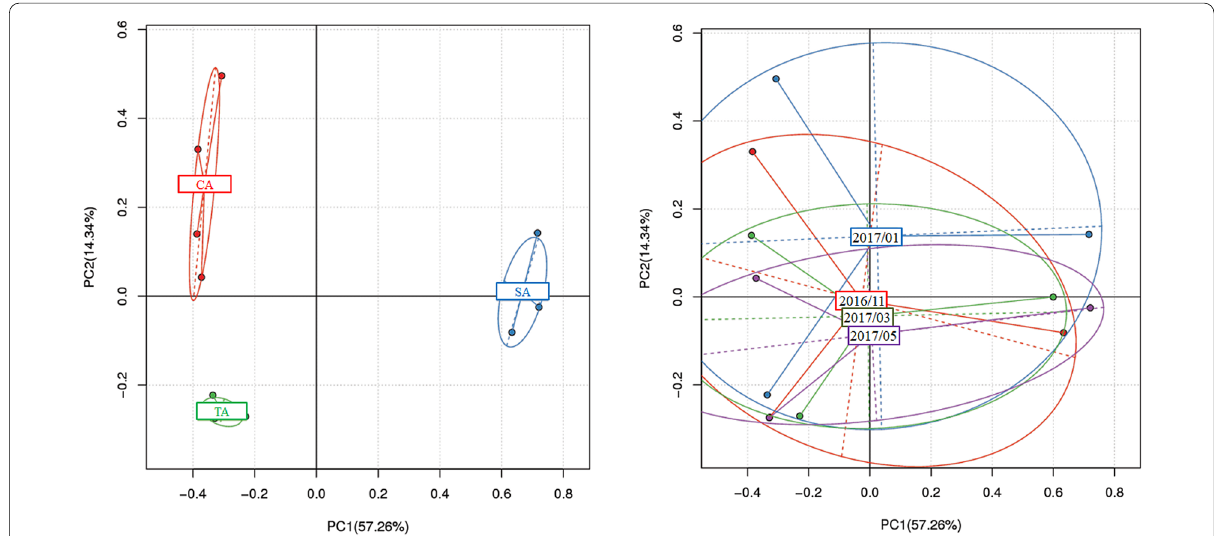
Fig. 5 Principal component analysis of OTUs obtained from CA, TA, and SA soils between November 2016 and May 2017. The x‑axis and y‑axis indicate principal component 1 (PC1) and principal component 2 (PC2), respectively. The clustering groups of samples are based on different agricultural management and sampling times. The PCAs were implemented by the R software